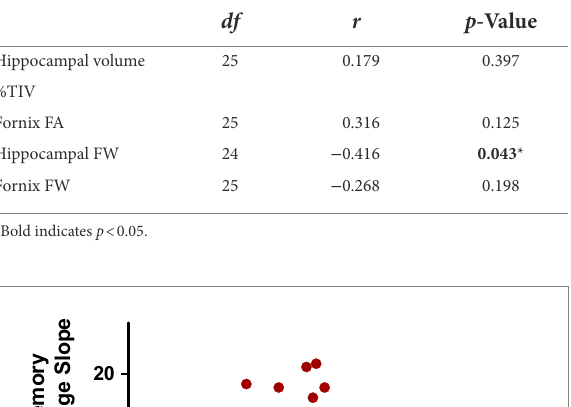
TABLE 3 Baseline hippocampal system metrics correlations with visual long-term memory change slopes in middle-age and older adults with autism spectrum disorder (ASD).